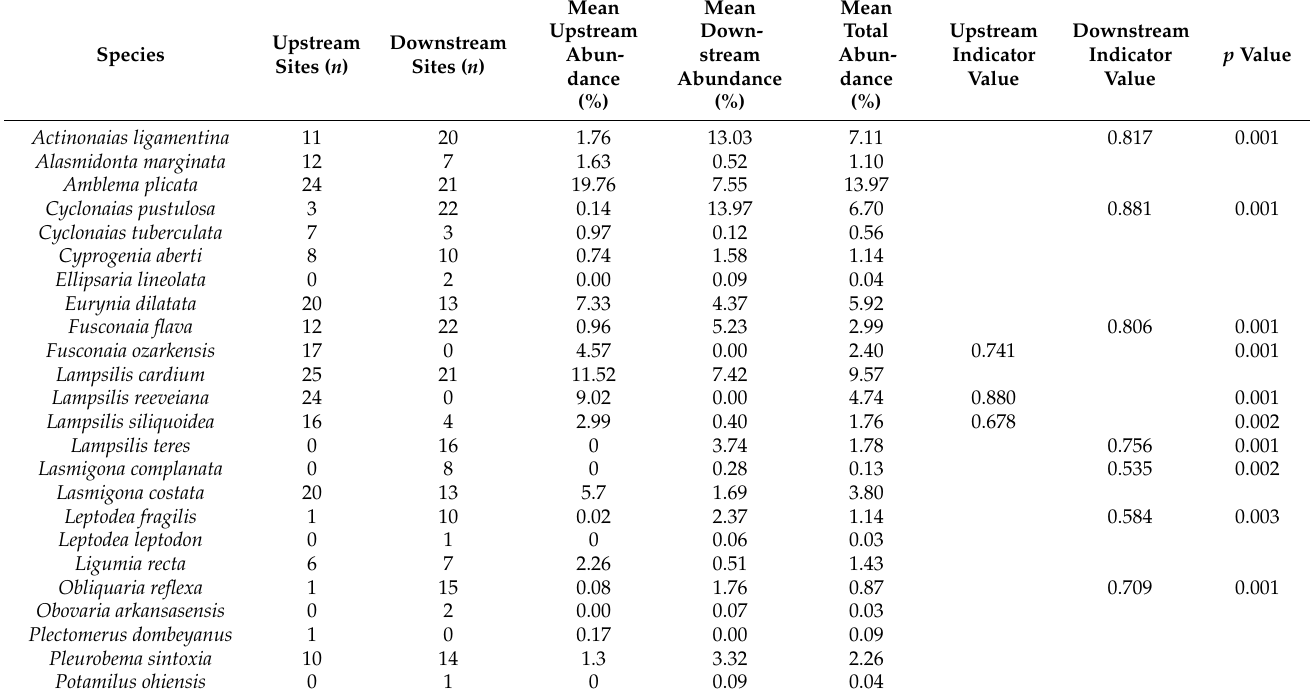
Table 2. Strawberry River freshwater mussel species occurrence at upstream and downstream assemblage group sites ( n = number of sites), mean % relative abundance of a posteriori upstream and downstream assemblage sites and total sites, and upstream and downstream assemblage group species indictor analysis correlations with associated p values. Nomenclature follows Williams et al.